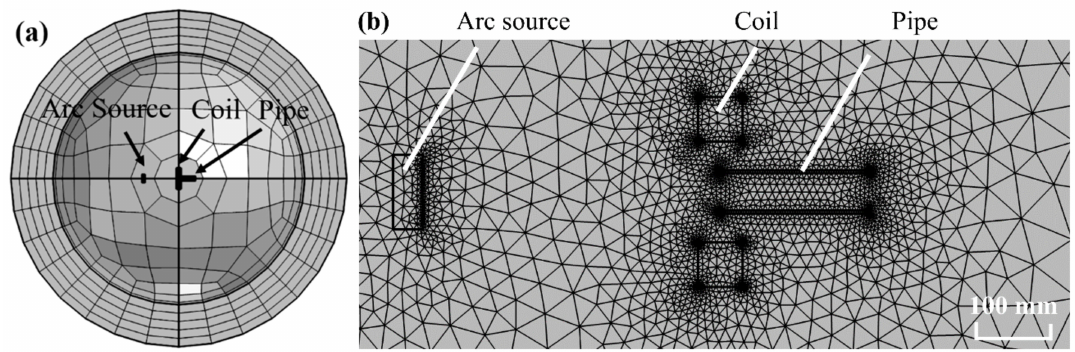
Figure 2. Mesh configuration: ( a ) General view of the mesh; ( b ) Detailed mesh of the arc source, coil and pipe.